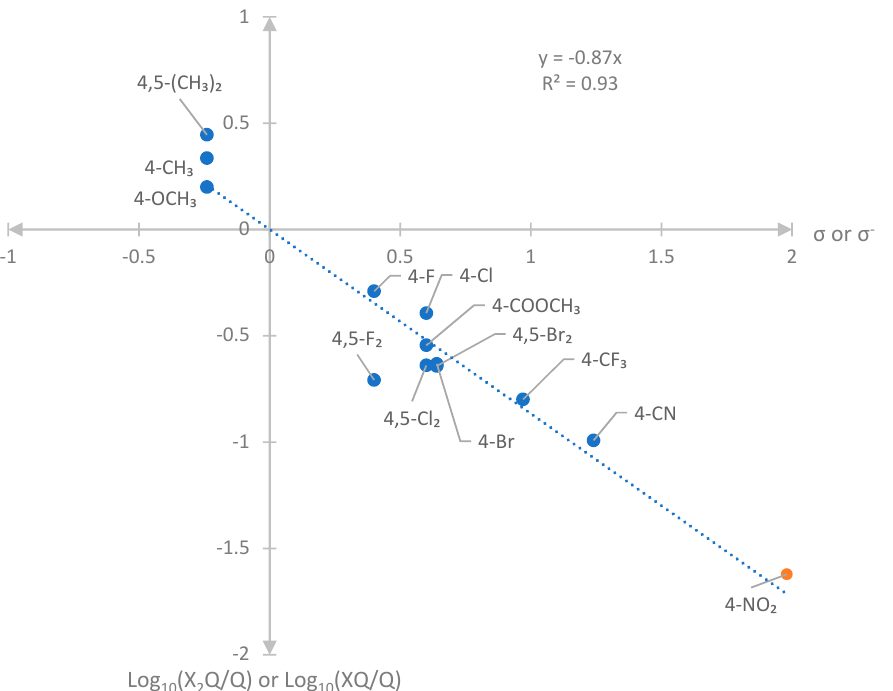
Figure 7. Hammett plot of XQ/Q or X 2 Q/Q ratio with standard composite σ constants except for X = NO 2 ( σ− constant, highlighted in orange).